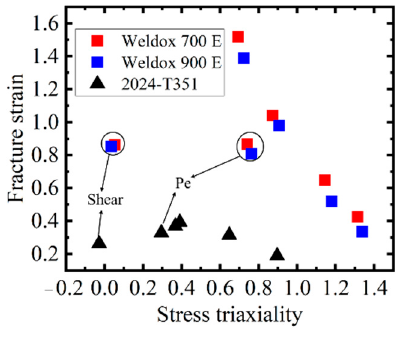
Figure 14. Comparison of the ductility of three metal materials.